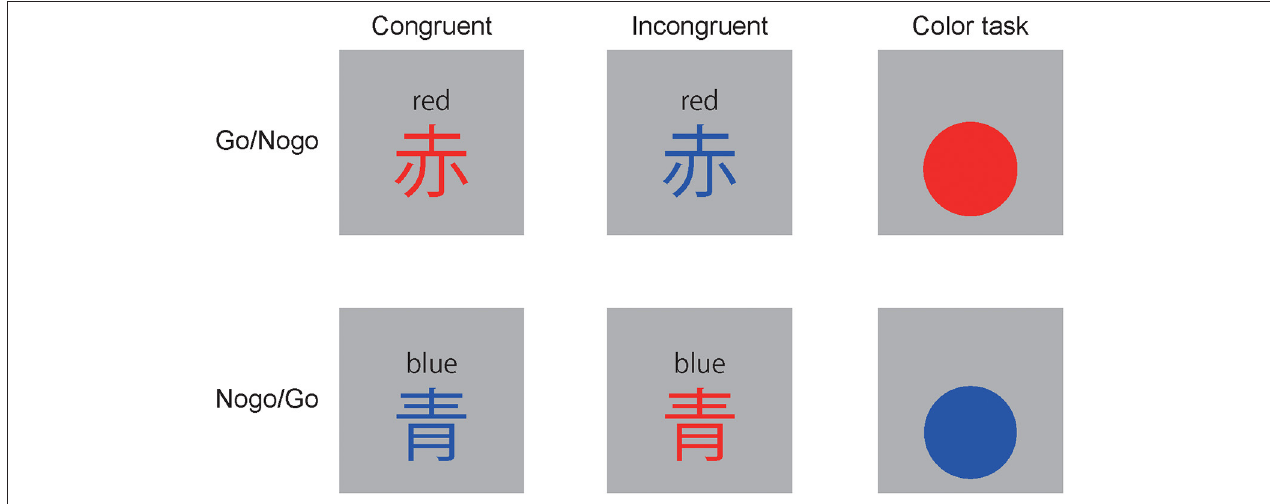
FIGURE 1 | Tasks: 赤 ” means “red,” “ 青 means “blue.” Stimuli were presented for 100ms with a stimulus onset asynchrony of